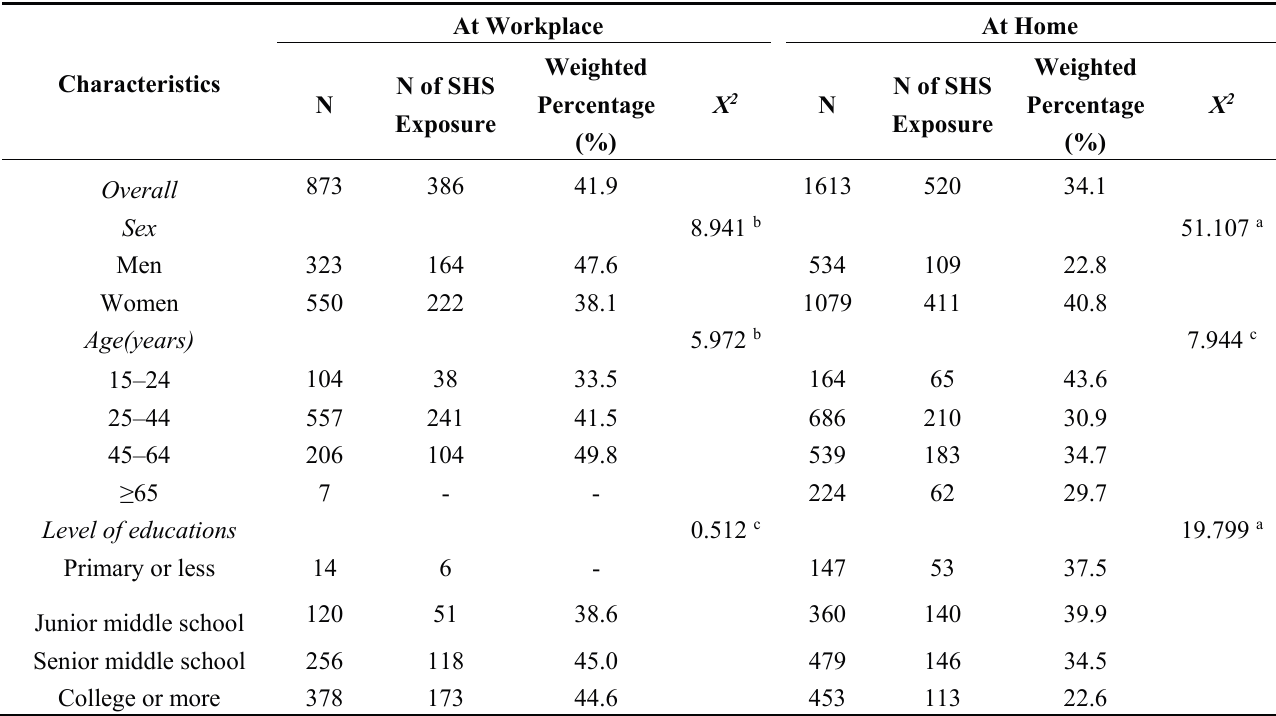
Table 4. Prevalence of second-hand smoke (SHS) exposure among non-smokers by sex, age group and level of education in the last 30